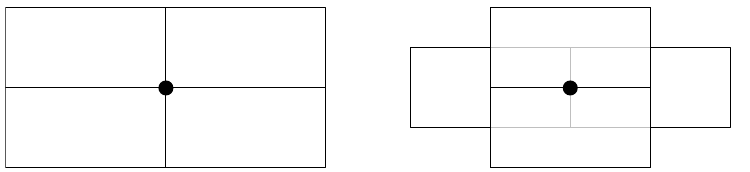
Figure 1. The four label candidates for a point in the four-position model ( left ) and the additional four label candidates in the eight-position model ( right